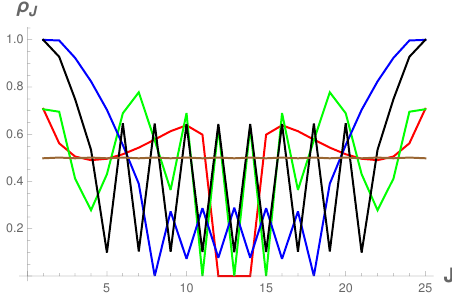
Figure 5 . The optimal values of (cid:26) found by solving (6.32) discretized into 25 parts J . The red, green, blue, black and brown curves correspond to (cid:11) equal to 0 : 2 ; 0 : 4 ; 0 : 6 ; 0 : 8 and 1 respectively. Note that when (cid:11) = 1 the optimal density is constant as expected.